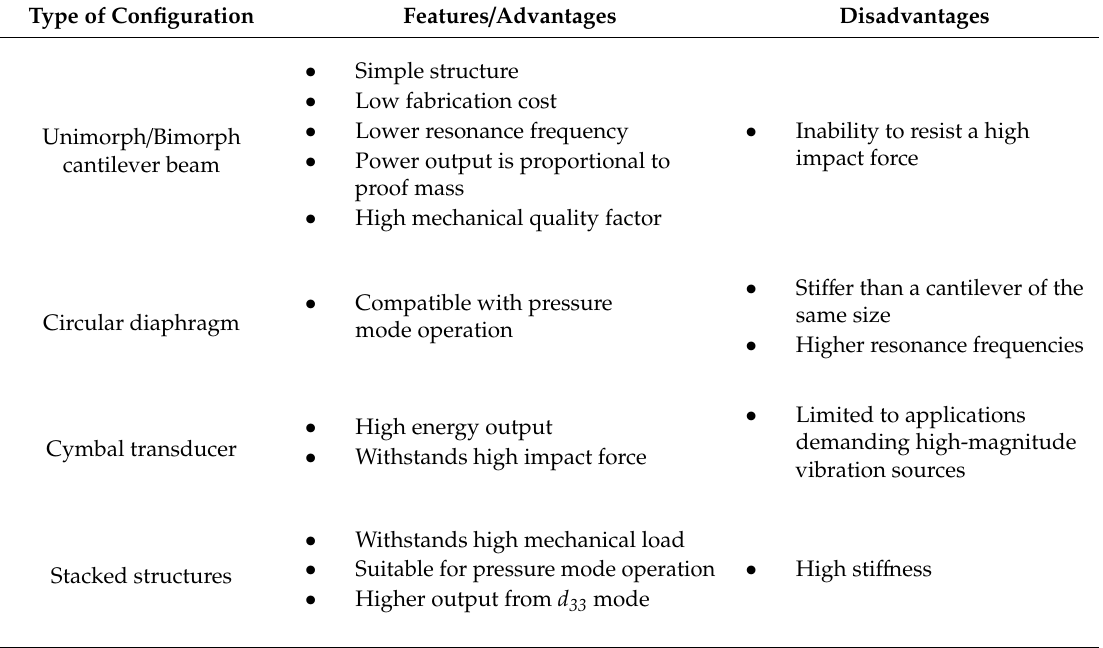
Table 5. Advantages and disadvantages of di ff erent configurations for piezoelectric